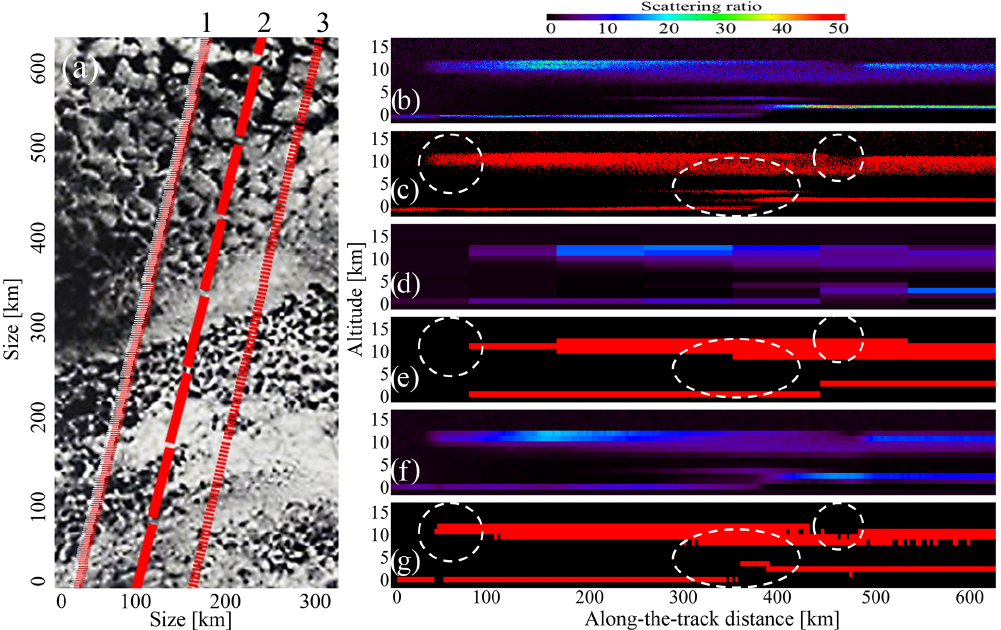
Figure 4. Effects of horizontal and vertical averaging on cloud detection. (a) Visible satellite image from the NASA Moderate Resolution Imaging Spectroradiometer (MODIS) showing horizontal cloud structure of the order of 5–7km; image from the NASA MODIS Rapidfire archive. Image scale is approximately 330km × 660km, and the artificial CALIPSO and Aeolus tracks are superimposed to illustrate the problem of averaging over long distances. 1 – CALIOP at 333m. 2 – ALADIN at 87km. 3 – ALADIN at 2.9km. (b) Simulated scattering ratio for CALIOP at its native resolution of 333m (H) and 60m (V). (c) CALIOP clouds. (d) Simulated scattering ratio for ALADIN converted to SR_532 at 1km (V) and 87km (H). (e) ALADIN clouds estimated for (d) . (f) Same as (d) but for 2.9km (H). (e) ALADIN clouds estimated for (f)